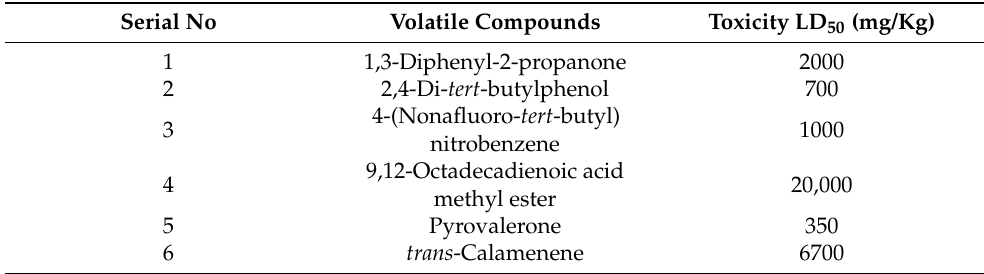
Table 8. Toxicity prediction based on the docking scores of active volatile components of CGJ using the ProTox-II tool.